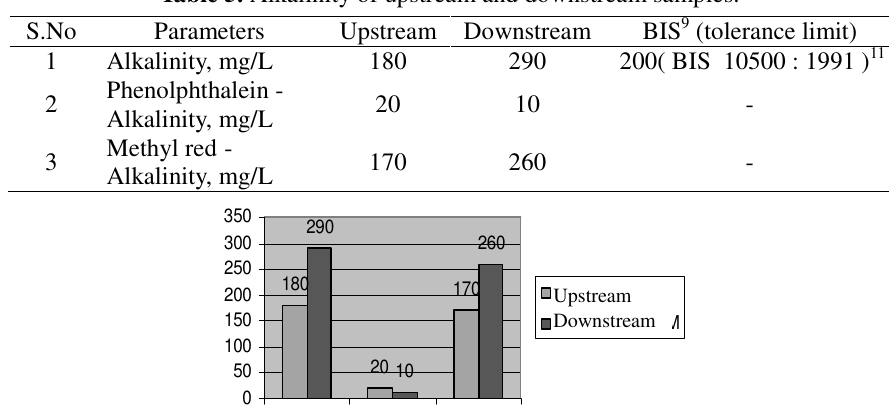
Table 5. Alkalinity of upstream and downstream samples.